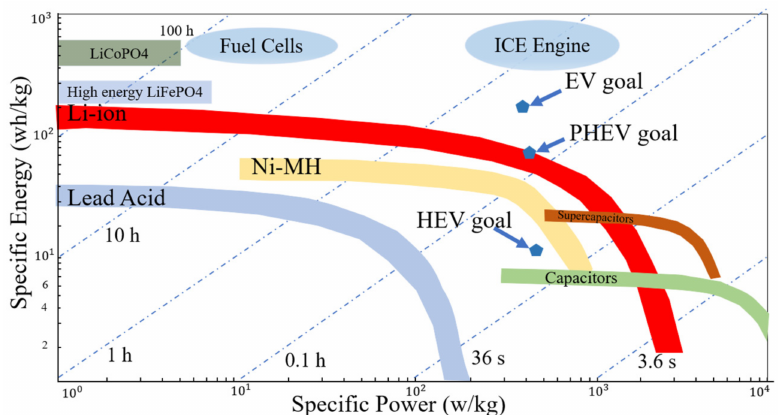
Figure 2. Ragone plot of various energy sources (adapted from [13]).